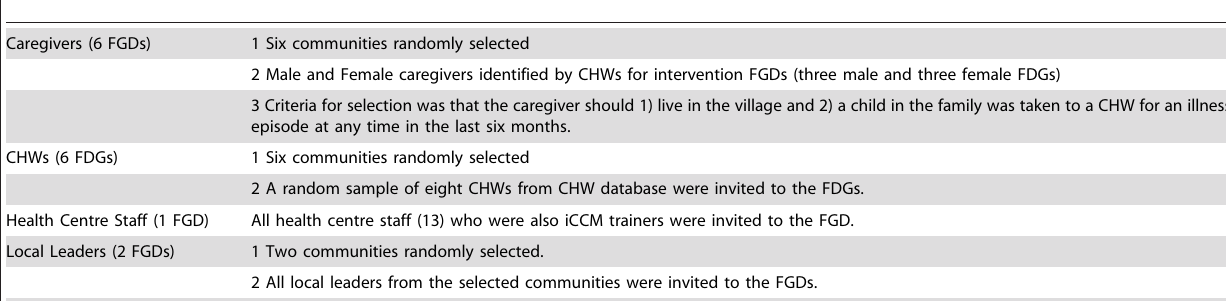
Table 2. Sampling Strategy for Focus Group